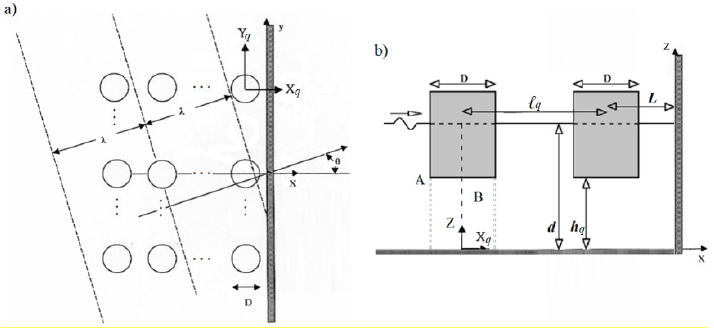
Figure 1. 2-D representations of a random array of N cylindrical Wave Energy Converters (WECs) in front of a breakwater: ( a ) plane view of array of N WECs in front of a breakwater; ( b ) side view of two adjacent WECs in front of a breakwater.